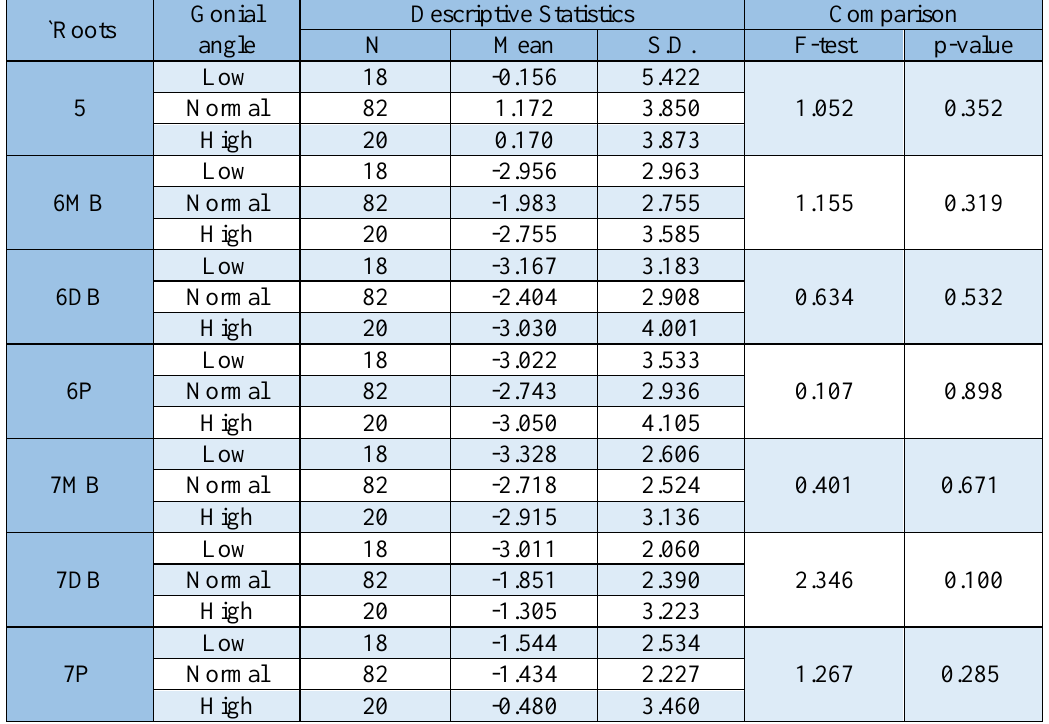
Table 4: Distances (mm) between root apices and the sinus floor on CBCT in different gonial angle